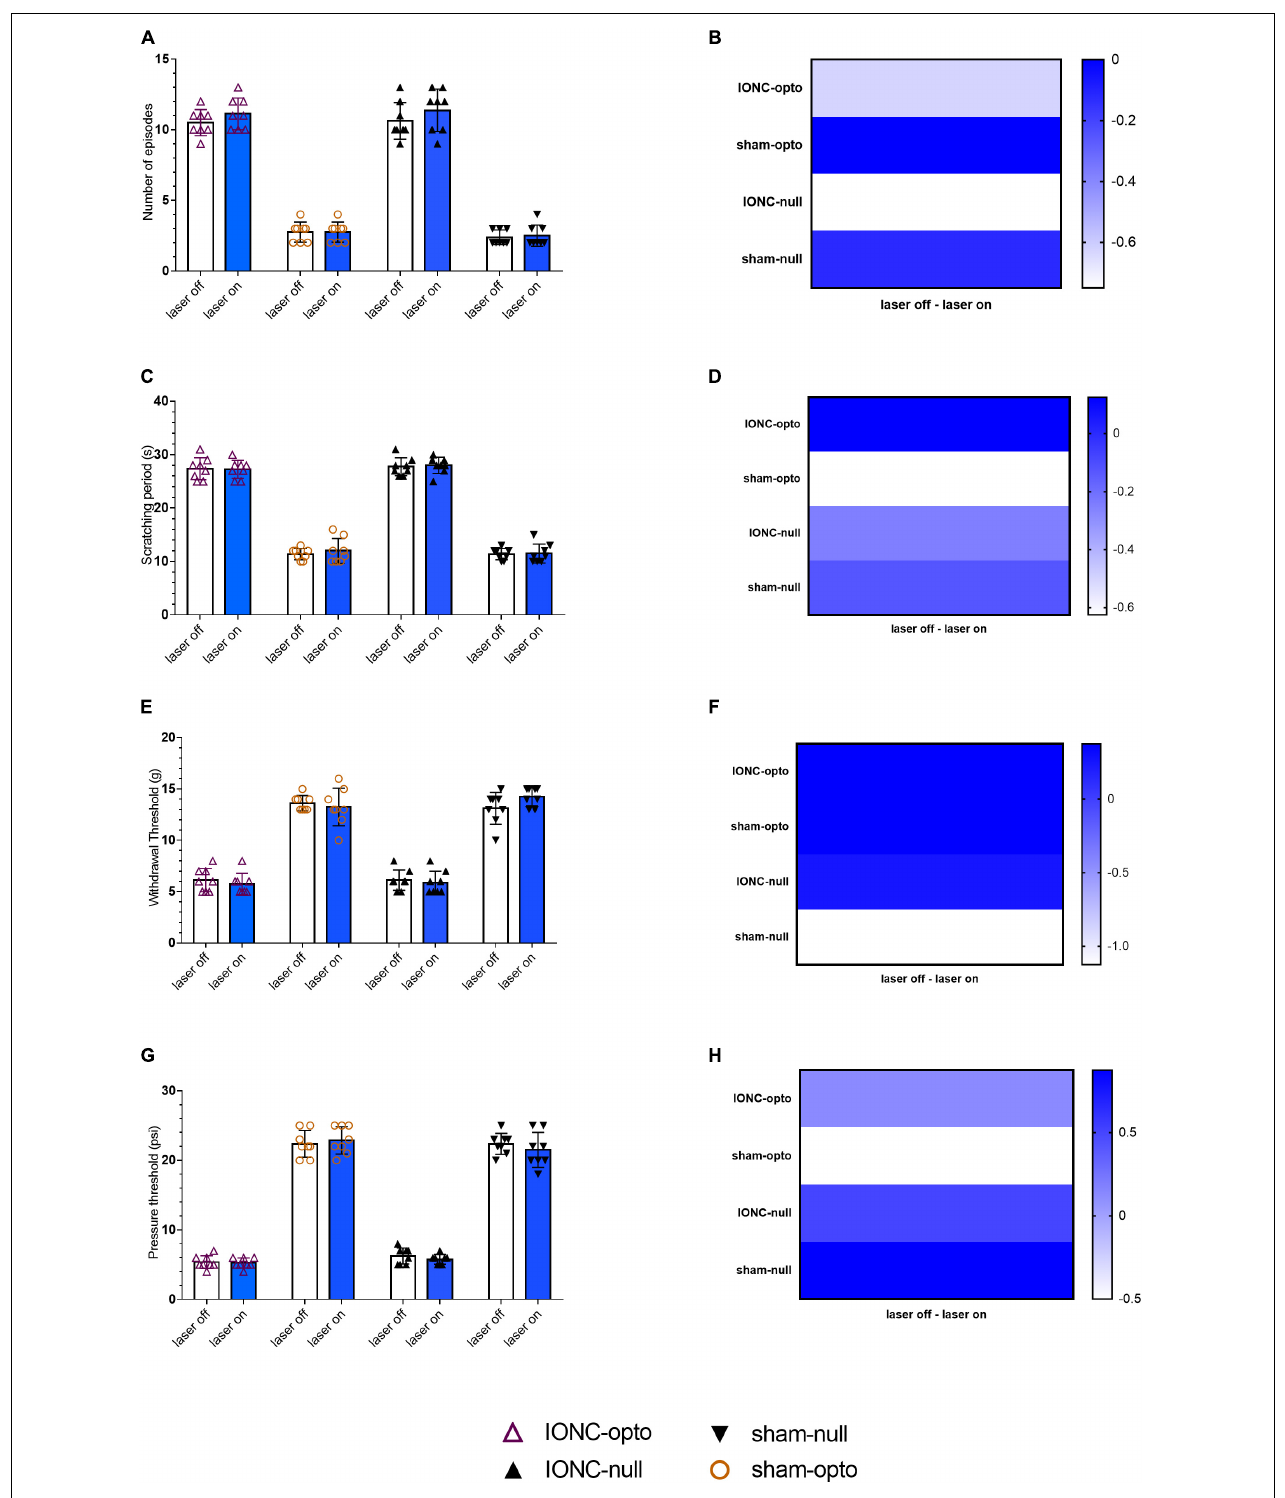
FIGURE 3 | Persistent hypersensitivity by TG optogenetic activation. (A) Sustained hypersensitive behavioral activity in response to blue laser stimulation in the face grooming test. (B) Heatmap for face grooming test. (C,D) Cold acetone test response to blue laser stimulation in TG neurons. (E,F) Persistent decreased air pressure threshold in the air puff test with blue laser stimulation in the IONC opto groups. (G,H) Mechanical threshold result in response to TG activation with a blue laser in the von Frey filament test. Data are presented as the mean ± SD. No significant differences were noted in two-way ANOVA.